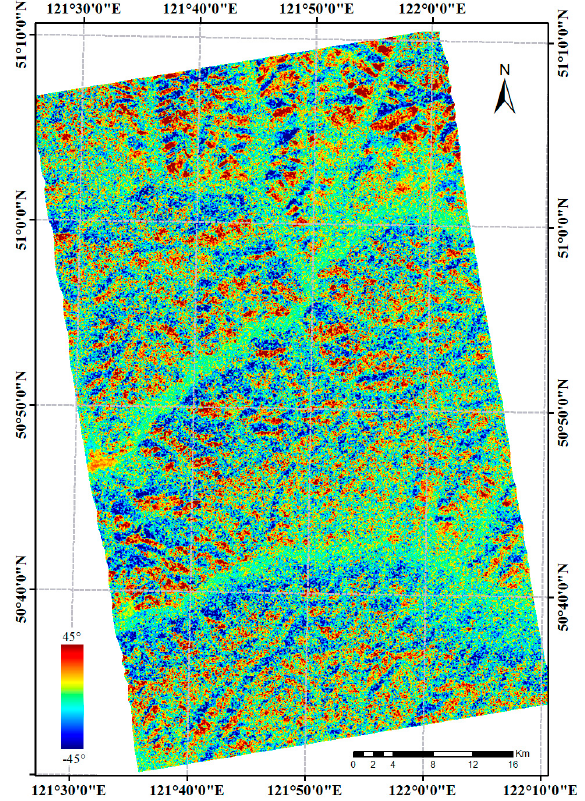
Figure 12. POA shift angle δ .